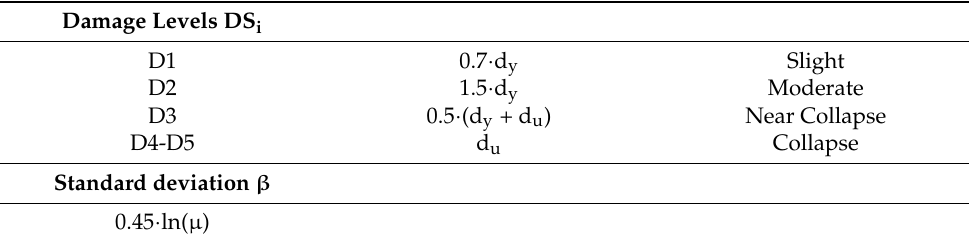
Table 5. Definition of damage levels and the corresponding standard